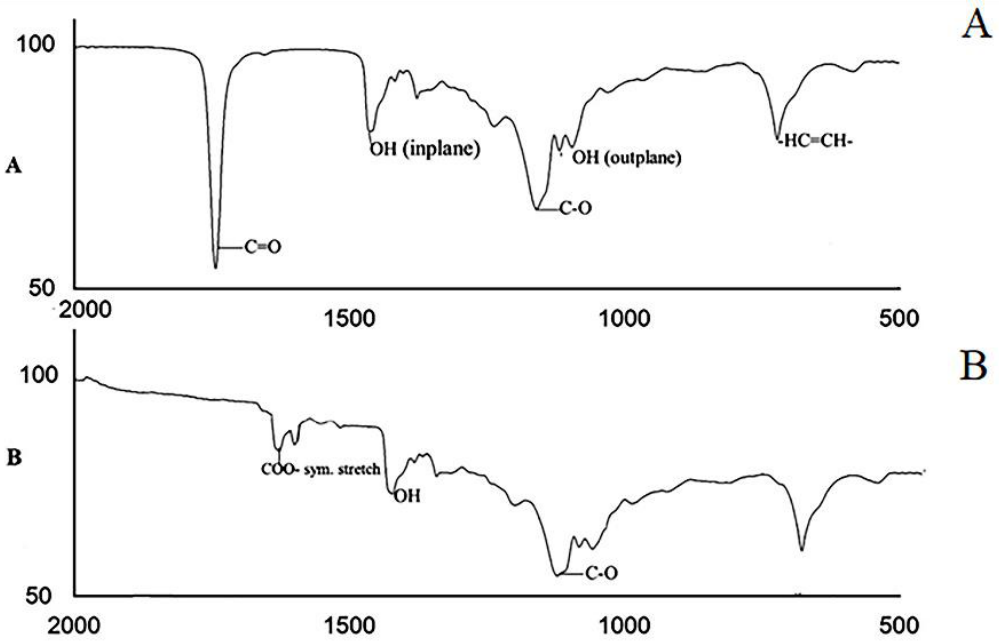
Figure 5. ( A ) FT-IR spectroscopy for oleic acid (C 18 H 34 O 2 ); ( B ) Cu particles with oleic acid